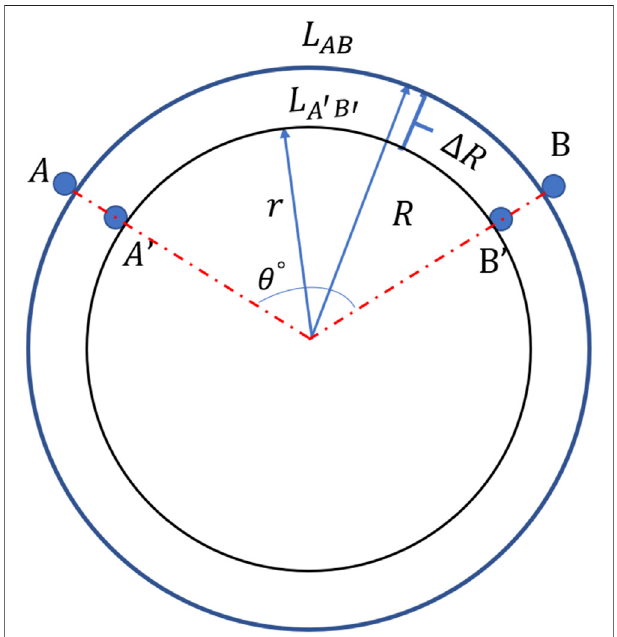
FIGURE1| Simpli fi edmodeloftheEarth. A , B and A ’ , B ’ denotethetwo points on the ground before and after the contraction of the Earth, respectively; R and r represent the radius of the Earth before and after contraction,respectively; L AB and L A ’ B ’ represent thedistancesbetween the two points before and after Earth ’ s contraction, respectively; and θ is the spherical angle corresponding to the two Δ L (cid:1) R Δ L (cid:1) r Δ L (cid:1) C Δ L . points. Δ R (cid:1) 360 2 πθ L AB L A ’ B ’